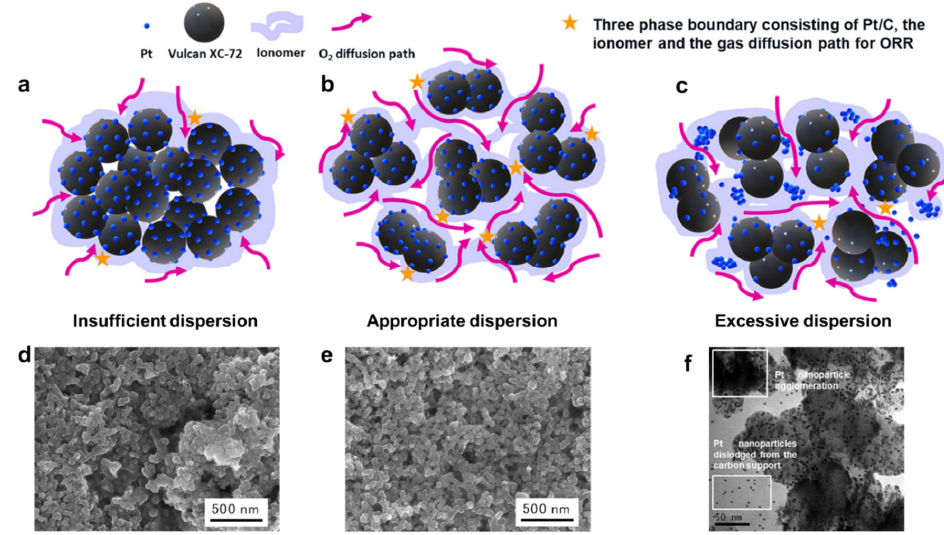
Figure 9. The structures of Pt/C-Nafion ionomer and CL with insufficient ( a , d ), appropriate ( b , e ), and excessive ( c , f ) dispersion. (( a – c ) Modified with permission from [156], Copyright (2019), American Chemical Society; ( d – e ) Reprinted with permission from [24], Copyright (2019), American Chemical Society; ( f ) Reprinted from [159], Copyright (2014), with permission from Elsevier).